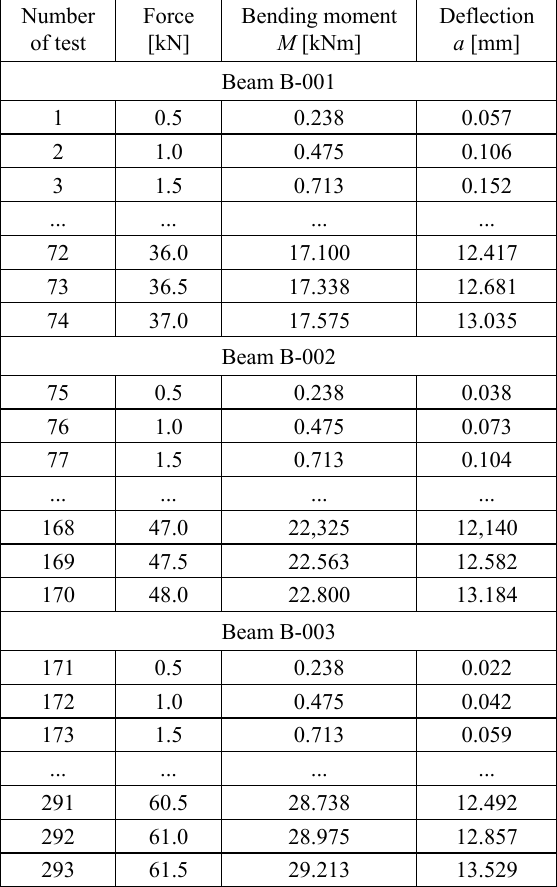
Table 1. Measured values of deflection